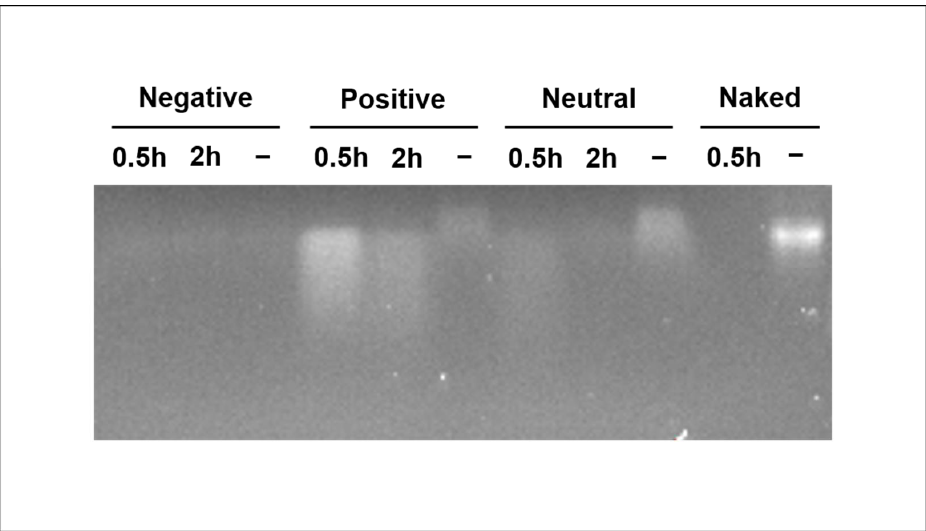
Figure 3. RNA integrity on gelatin nanoparticles. Integrity of RNA loaded to gelatin nanoparticles (lane 1–9) or naked RNA (lane 10 and 11) with (0.5 h and 2 h) or without ( − ) exposure to RNase A. Naked refers to RNA without any vector or particle.